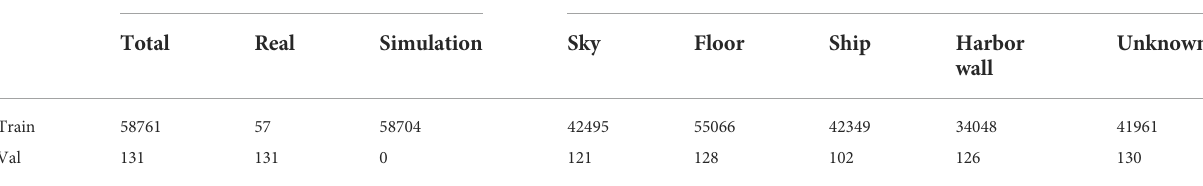
TABLE 2 Dataset used for training and validating the semantic segmentation networks. Total of images in dataset